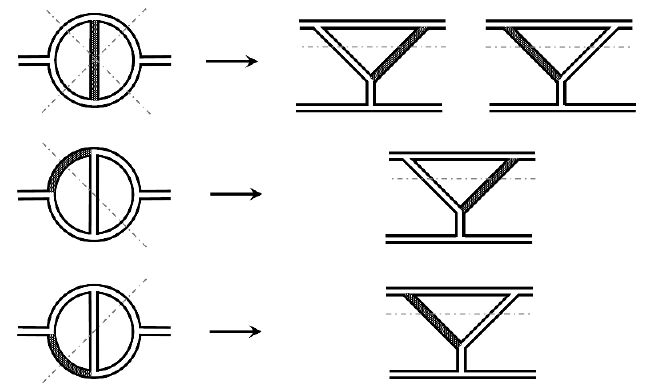
Figure 11 . The procedure showing how to obtain topological structures of rungs representing the interference terms between the number changing processes in the collinear regime. Only few representative structures are